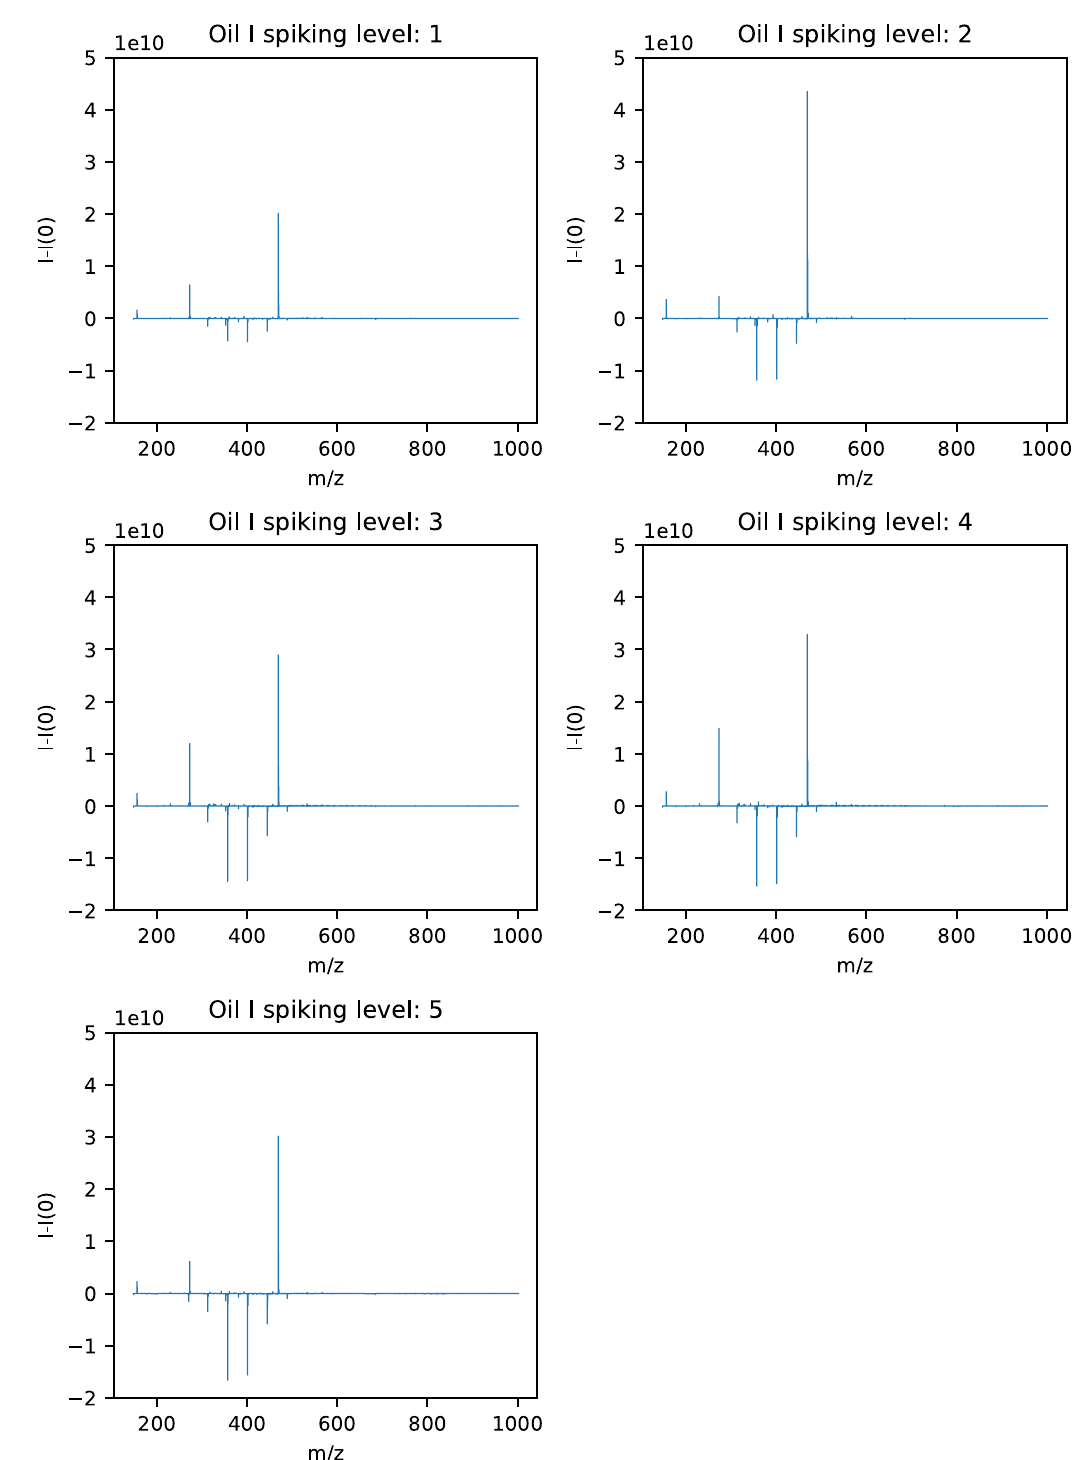
Fig 6. Mass spectra of samples from the hydrate phase for oil I with spiking level 0 subtracted from each of the spiking levels 1–5.